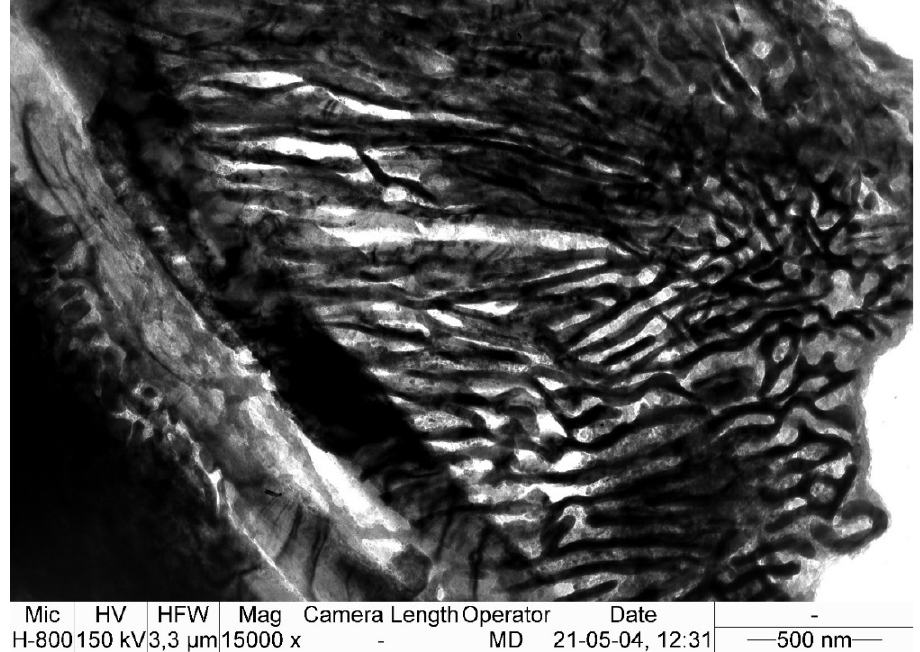
Figure 4. Microstructure of the X120Mn12 steel after isothermal annealing at 510 °C and cooling with the furnace. Brightfield image of a “thin” carbide about 0.35- μ m thick at the grain boundary of the former austenite and a fine pearlite colony growing on it. TEM.